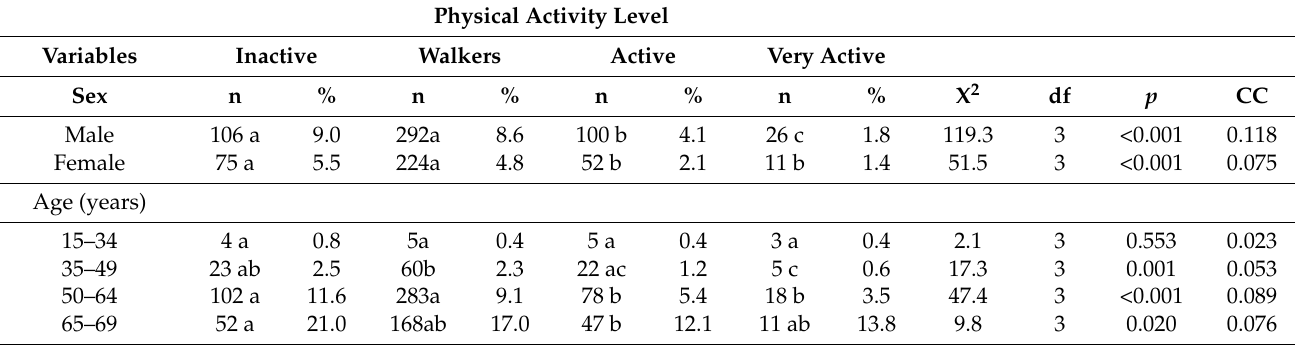
Table 4. Diabetes Medication Use prevalence by the Physical Activity Level (PAL) and Sex, Age and Body Mass Index (BMI).